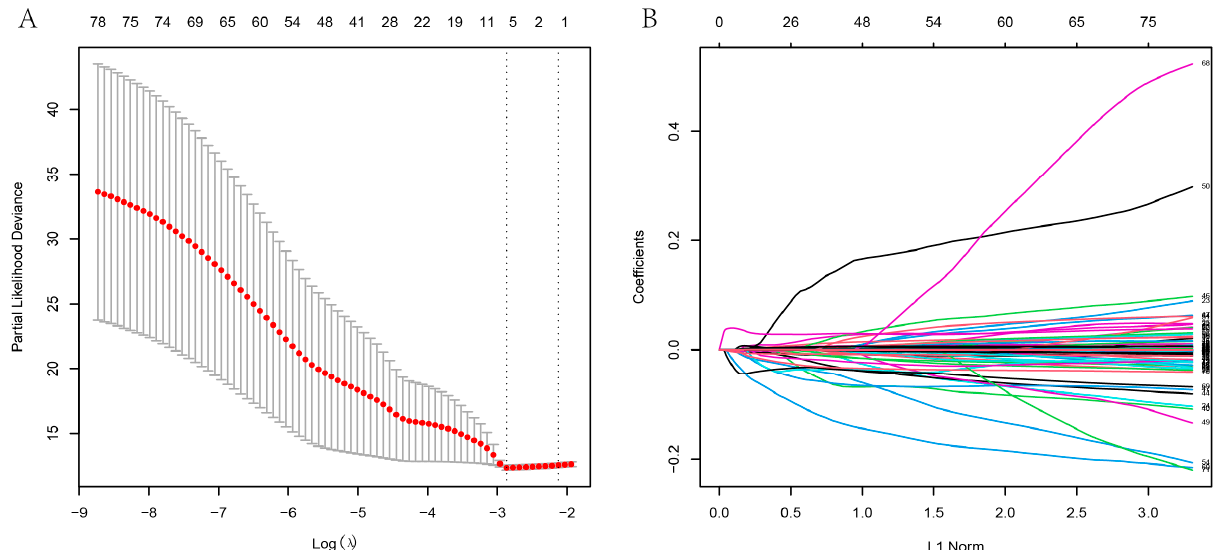
Figure 5. LASSO regression of candidate hub genes. ( A ) The solid lines were the partial likelihood of deviance. The dotted vertical lines drawn on the right indicated the optimal values of log( λ ) through 10-fold cross-validation. ( B ) LASSO coefficient profiles of candidate hub genes. Each curve represented a gene. The curve displayed the path of gene’s coefficient against the L1-Norm. The number of nonzero coefficients at the current was defined as the effective degrees of freedom (df) for the LASSO.